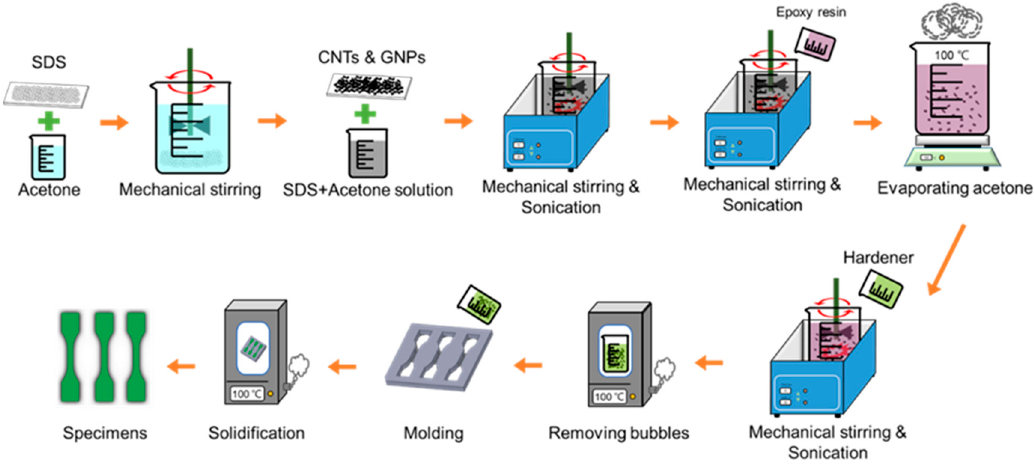
Figure 1. Fabrication process of the studied nanocomposite specimens.